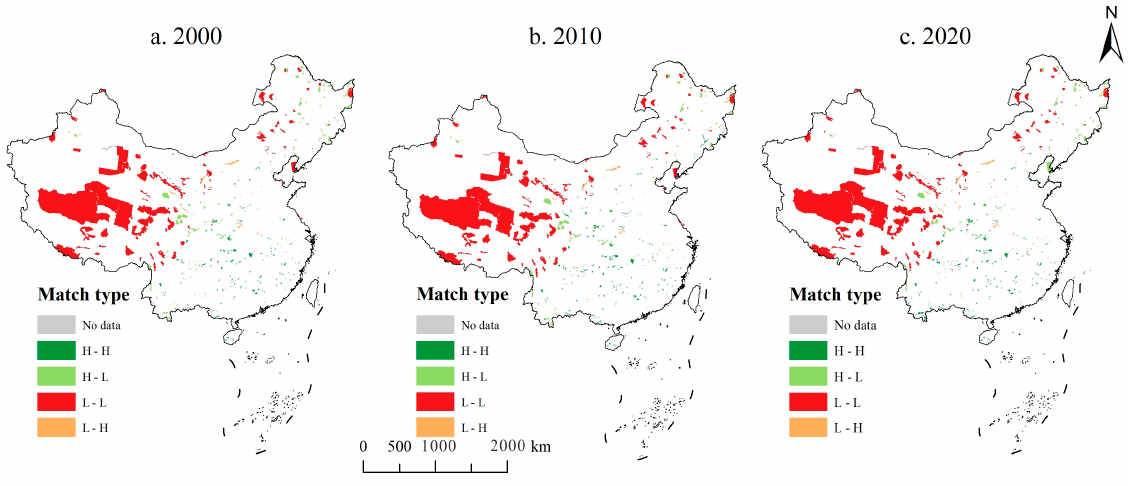
Figure 4. Ecosystem service supply and demand matching pattern in nature reserves from 2000 to Table 3. Transfer of matching supply and demand for ecosystem services from 2000 to 2020.